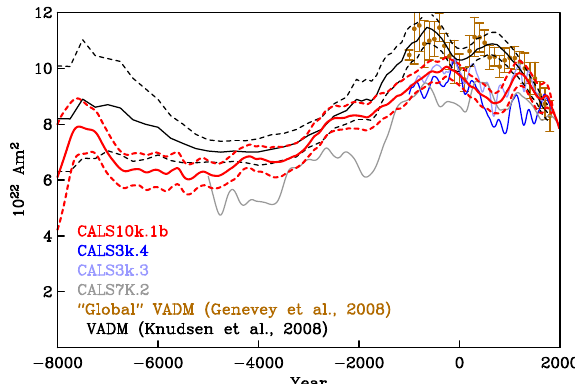
Fig. 3. Dipole moment predicted by spherical harmonic field models CALS10k.1b (red), CALS3k.4 (blue), CALS3k.3 (light blue), CALS7K.2 (grey) and by the archeomagnetic VADM reconstruc- tions by Knudsen et al. (2008) (black) and Genevey et al. (2008) (brown) with uncertainty estimates (dashed lines and error bars) as provided by the authors, see text for details. Uncertainty estimates for CALS3k.3 and CALS3k.4, which are similar to those for CALS10k.1b, have been omitted to avoid cluttering the